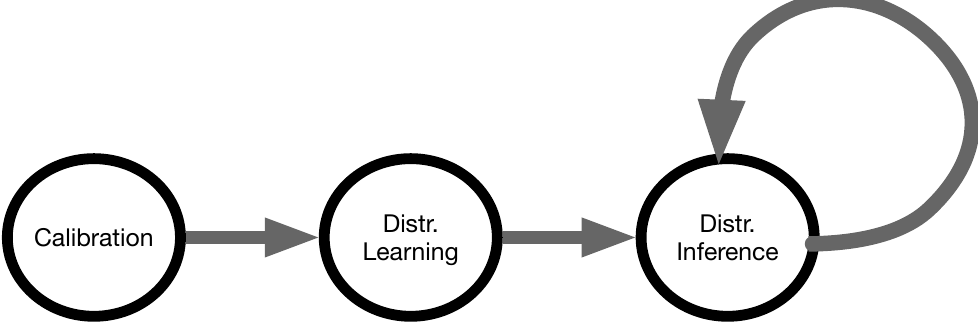
Figure 2. EDISON operational states. Calibration and distributed learning are employed once, in the beginning of operation, after which distributed inference is the standard operative state. Table 1. Symbols in EDISON algorithms and